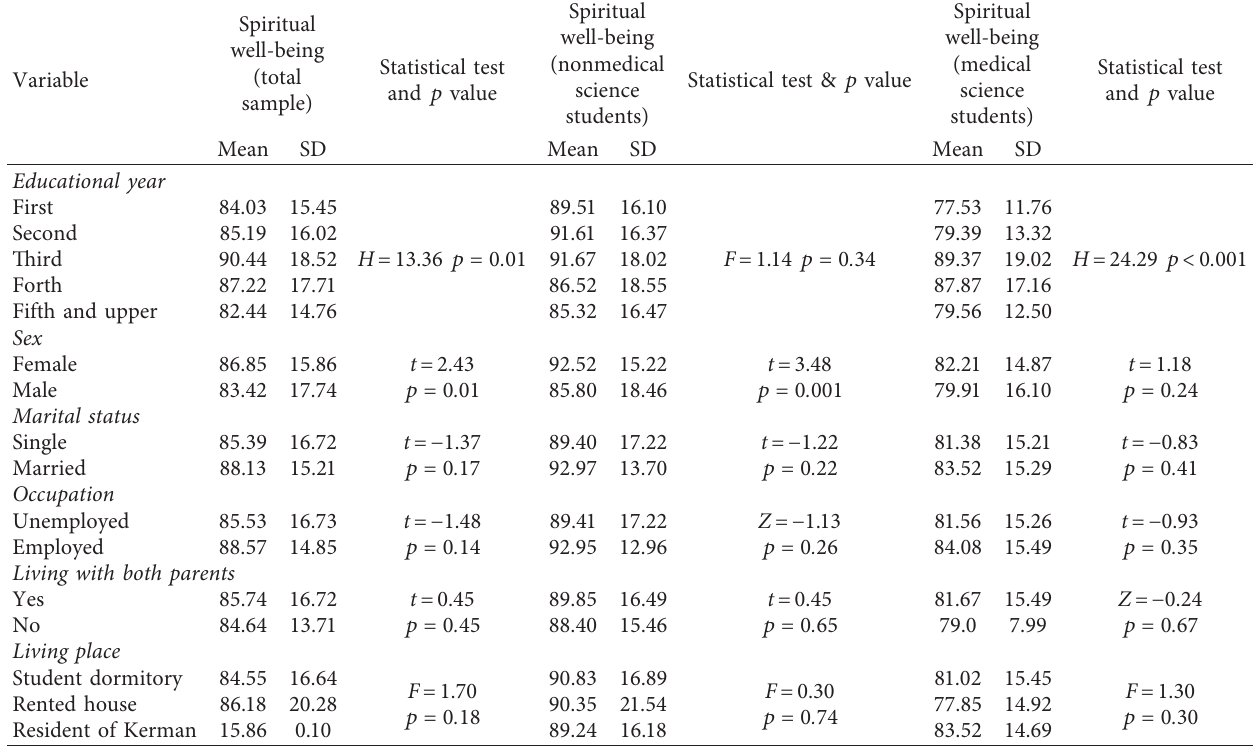
Table 3: Scores of spiritual well-being regarding demographic variables of